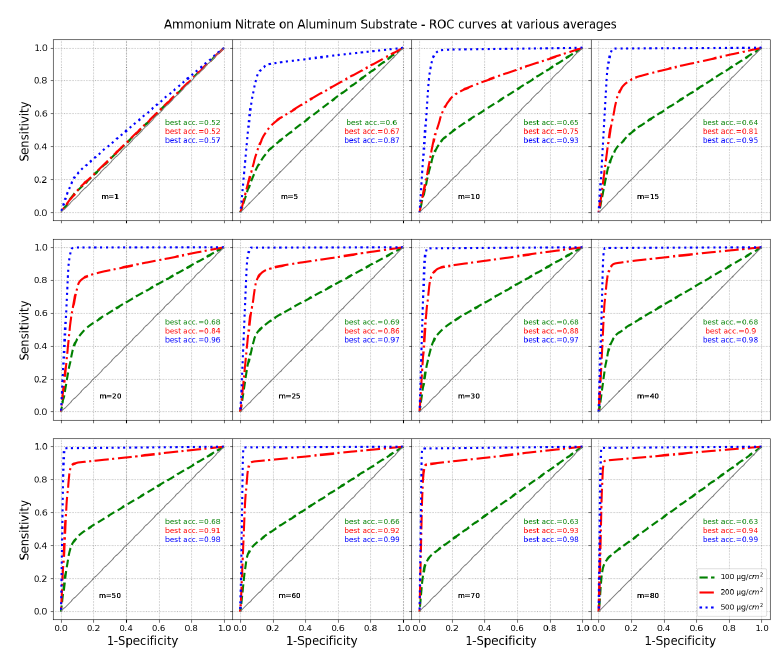
Figure 7. AUCs and best accuracies for ammonium nitrate over aluminum substrates for 100, 200 and 500 µ g/cm 2 and for signal averaged over a different number of single-shot